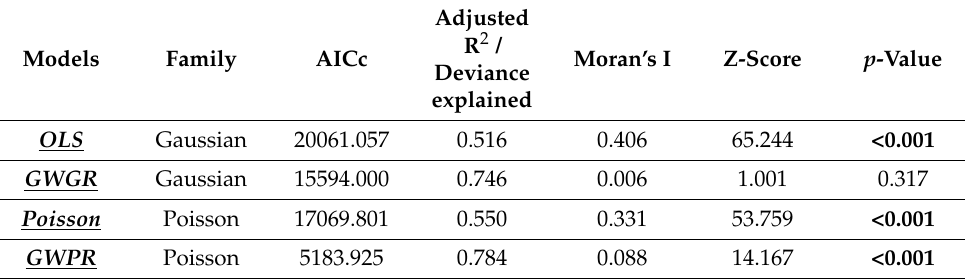
Table 5. Comparison of the performance of the four models.